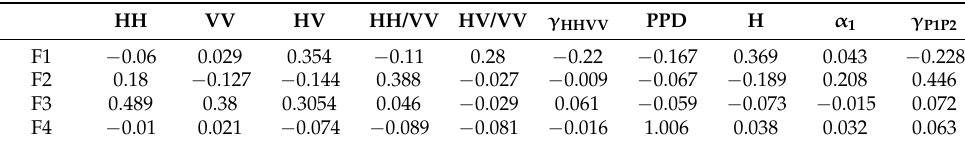
Table 3. Factor adjustment coefficients for each